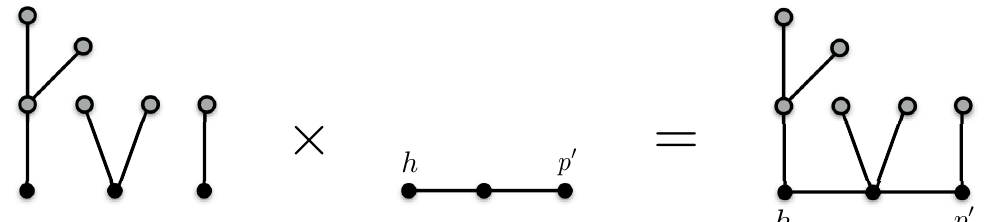
( { θ } ) form a spanning tree by merging i i ∈ α 2 | α |